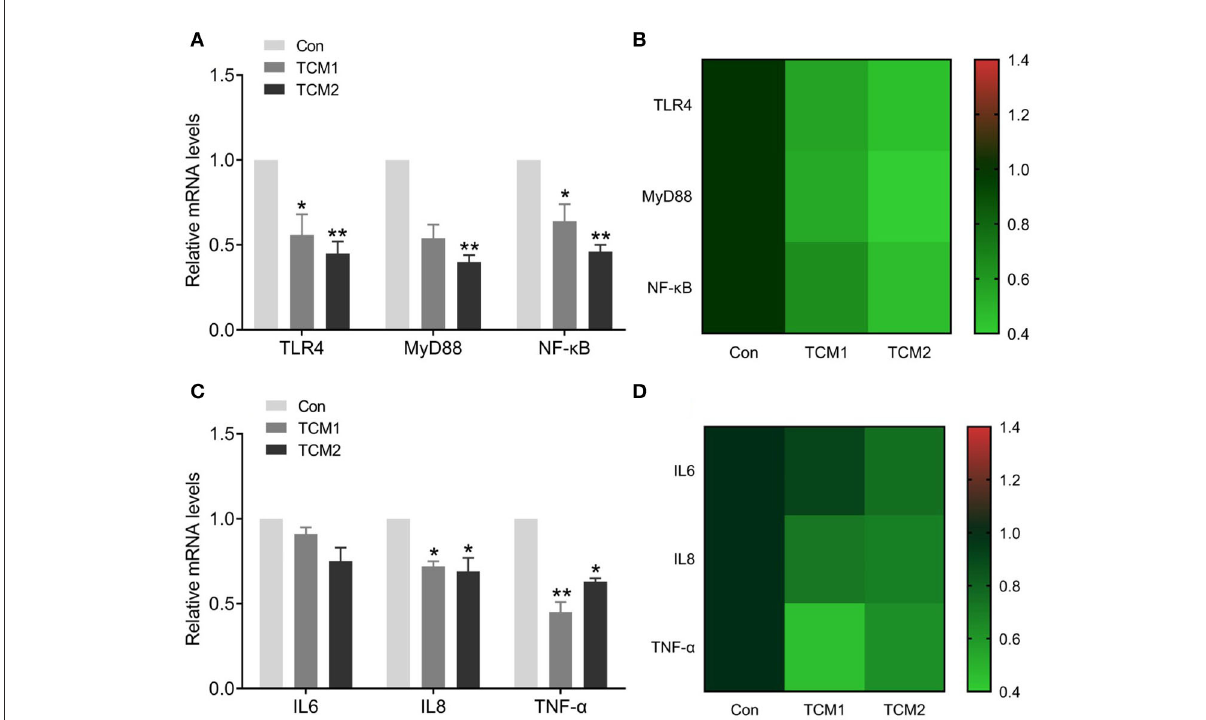
FIGURE4 Effects of TCM supplement on mRNA levels of the TLR4/MyD88/NF- κ B signaling pathway and inflammatory cytokine genes. (A) Effects of TCM supplement on mRNA levels of TLR4/MyD88/NF- κ B pathway-related genes. (B) Heat map shows the mRNA levels of TLR4/MyD88/NF- κ B